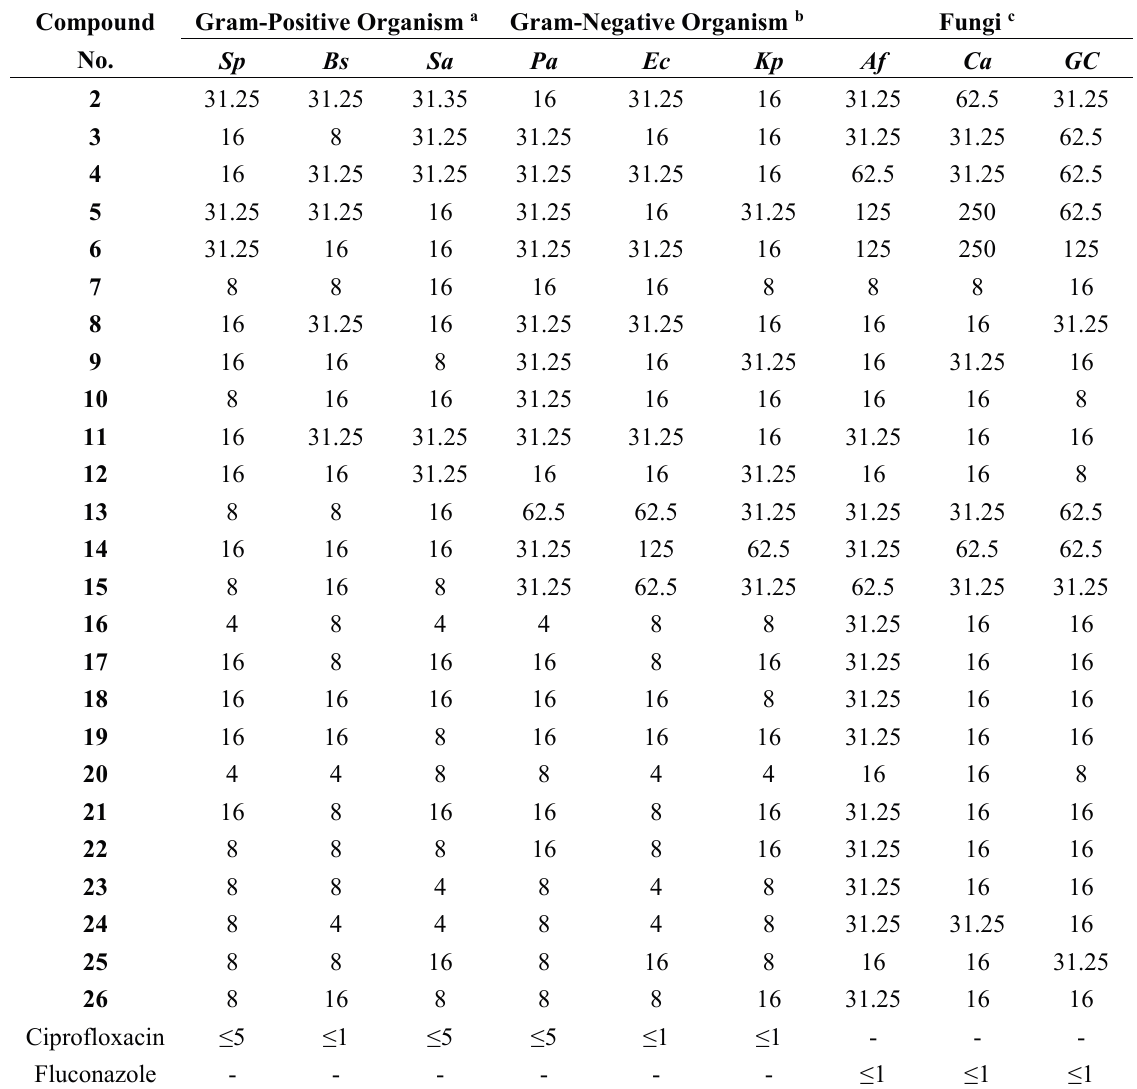
Table 1. Antimicrobial activity expressed as MIC ( μ